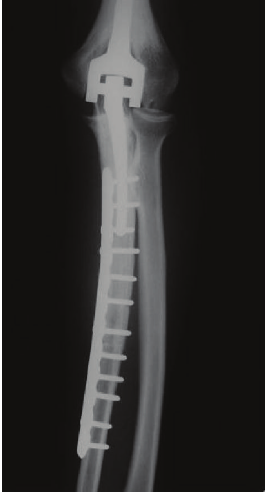
Figure 1: Anteroposterior radiograph of an osteoarticular allograft of the proximal humerus after 5 years of reconstruction.